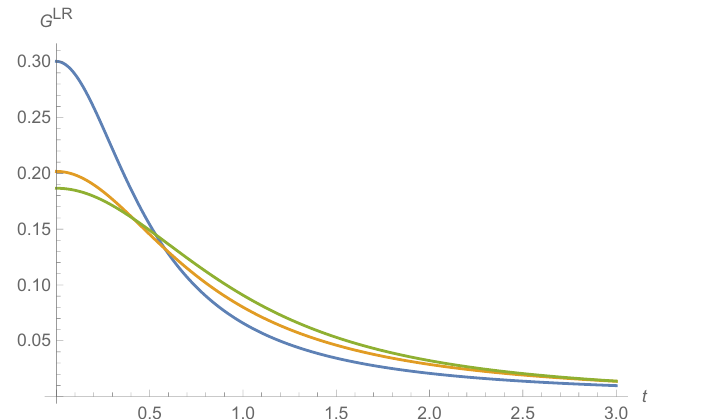
= 0 . 9 (blue), 0 . 7 (orange) b